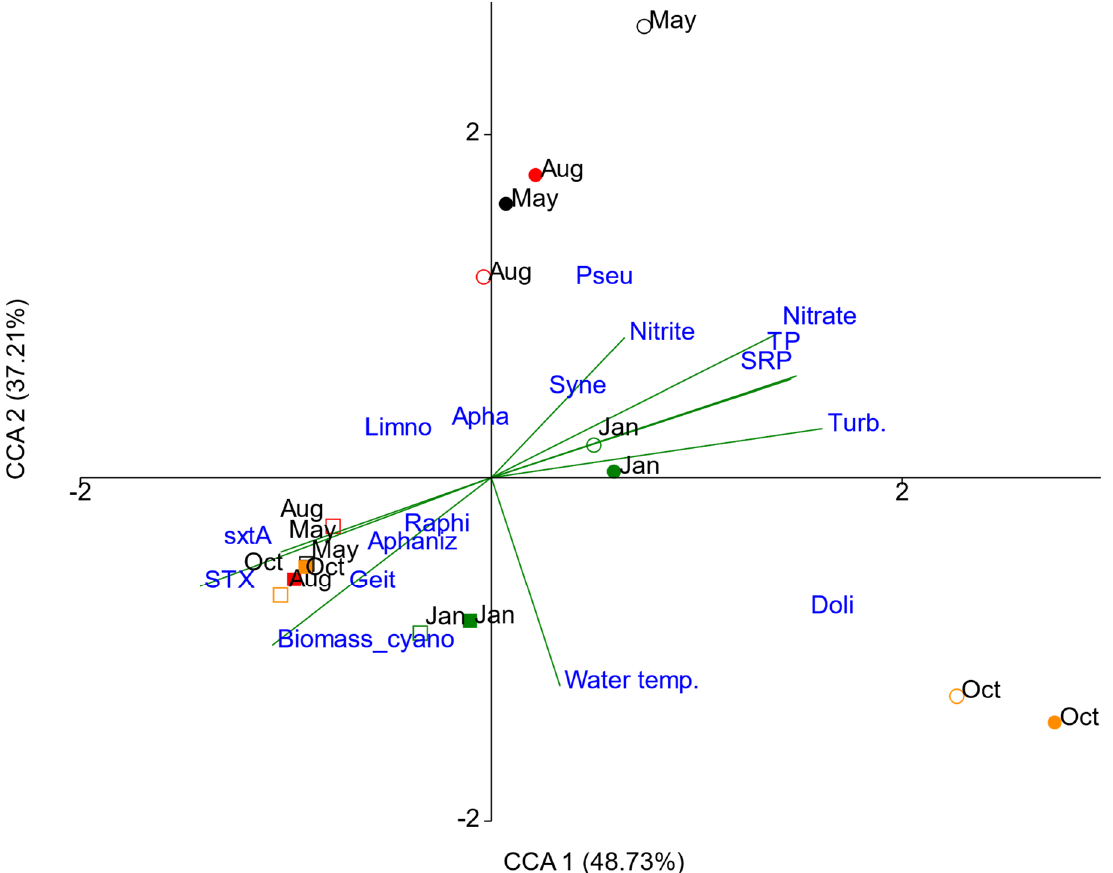
Figure 7. Canonical correspondence analysis (CCA) biplot of cyanobacteria biovolume and environmental variables in Itupararanga reservoir. The periods of sampling were May (May 2017, black), Aug (August 2017, red), Oct (October 2017, orange) and Jan (January 2018, green); the riverine zone is represented by dot and dam zone is represented by square; filled dot/square represents the depth 100 (surface); empty dot/square represents the depth 1 (lower limit of euphotic zone). Water temp. = water temperature; Biomass_cyano = cyanobacterial biomass determined by pigment analysis; STX = saxitoxin; SRP = soluble reactive phosphorus; TP = total phosphorus; Turb. = turbidity; Geit = Geitler- inema , Aphaniz = Aphanizomenon , Raphi = Raphidiopsis , Limno = Limnothrix , Apha = Aphanocapsa , Syne = Synechocystis , Pseud = Pseudanabaena , Doli = Dolichospermum